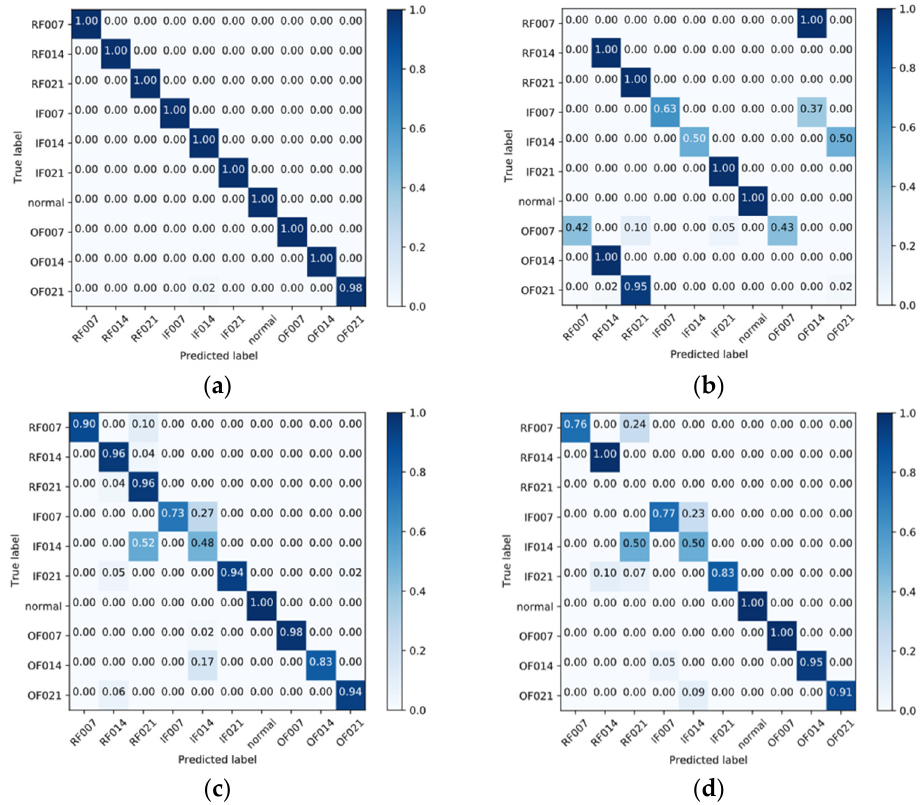
Figure 5. Confusion matrices of the different models for transfer learning task A–D (the color of the background becomes darker as the values get larger). ( a ) 1D-LDSAN; ( b ) 1D-CNN; ( c ) DDC; ( d ) DANN. T-distributed stochastic neighbor embedding (t-SNE) [48] is used for nonlinear